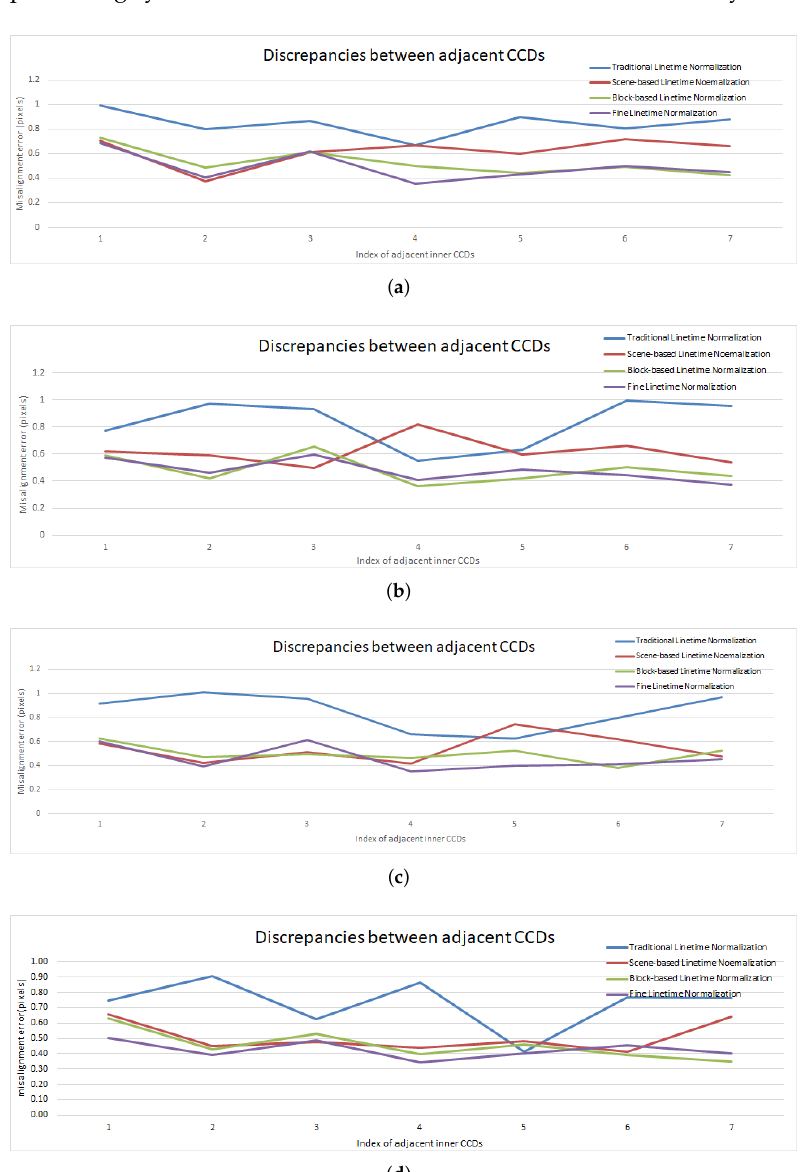
Figure 16. Geometric error between adjacent CCDs of different datasets: ( a ) geometric error be- tween adjacent CCDs in image data 1, ( b ) geometric error between adjacent CCDs in image data 2, ( c ) geometric error between adjacent CCDs in image data 3, ( d ) geometric error between adjacent CCDs in image data